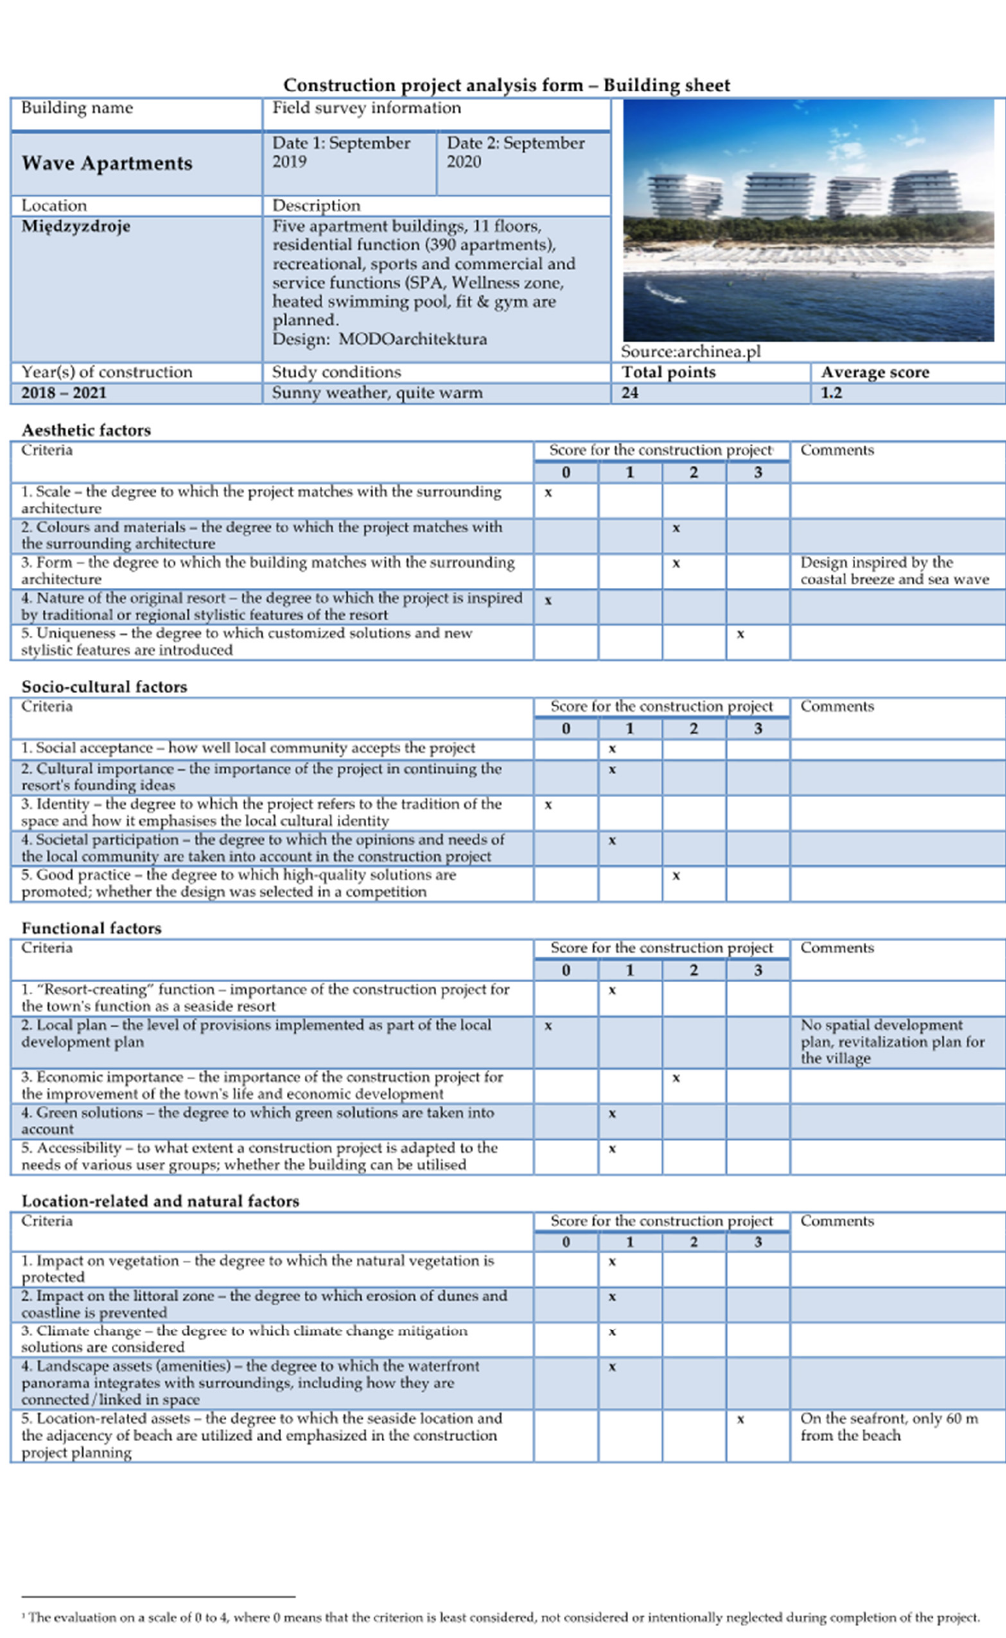
Figure A11 . Wave Apartments in Mi ę dzyzdroje. Building sheet. Figure A11. Wave Apartments in Mi˛edzyzdroje. Building